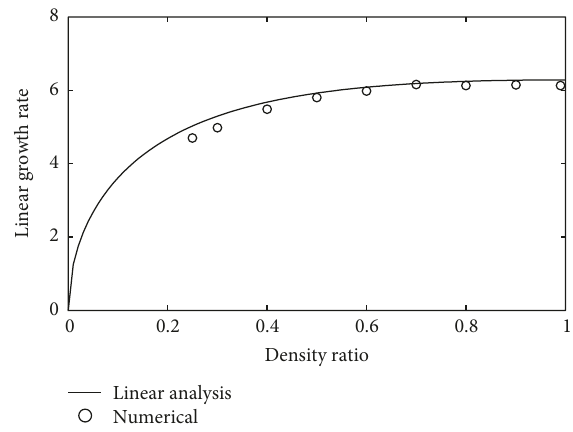
Figure 2: Comparison of simulation results with analytical